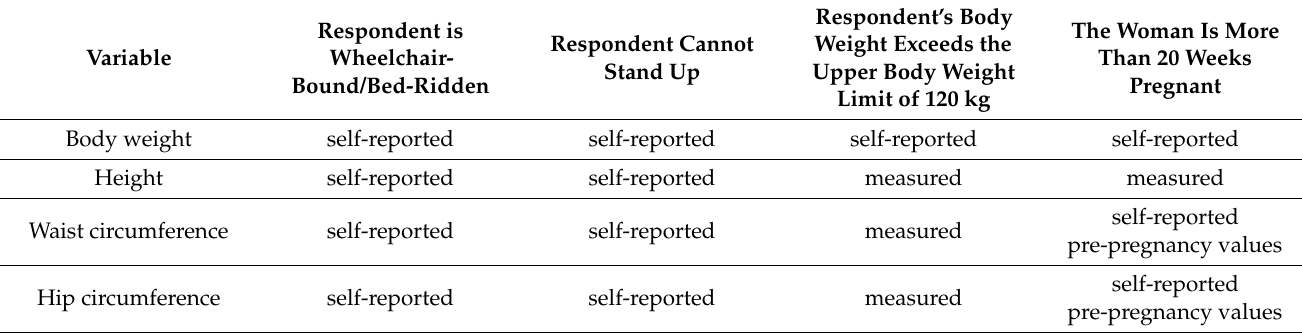
Table 2. Scheme for anthropometric measurements depending on respondents’ overall health and physiological status.